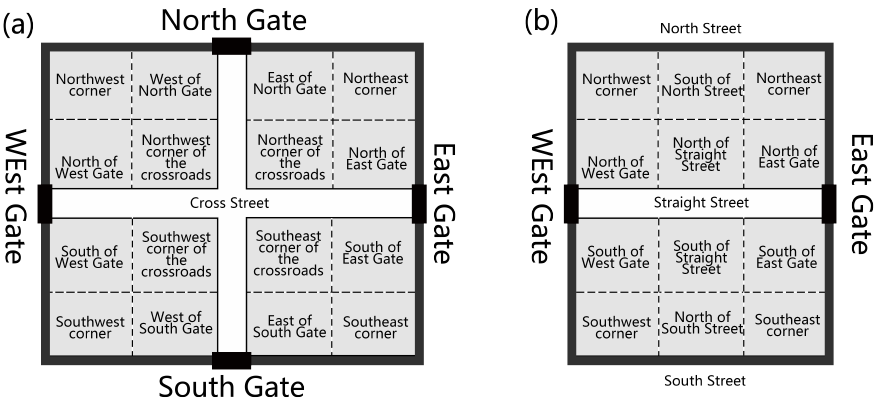
Figure 11. Two types of internal location map of the Fang in Chang’an [65]. ( a ) Nearly square-shaped Fangs, with doors on all sides. ( b ) Rectangular Fangs with only two side